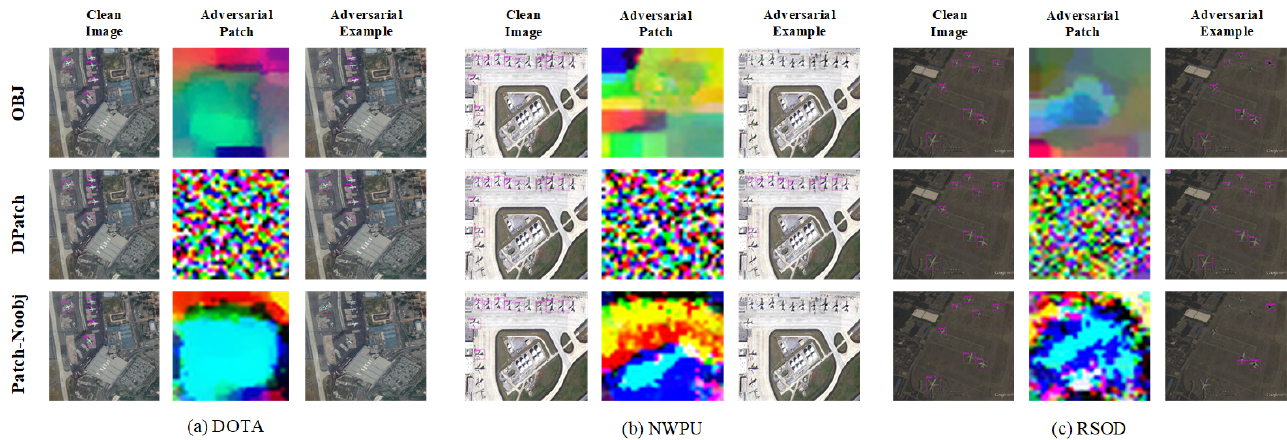
Figure 2. Visual and attack effects of adversarial patches on different datasets. In each subfigure, each row represents the visual and attack effect of the adversarial patch generated by one attack method.